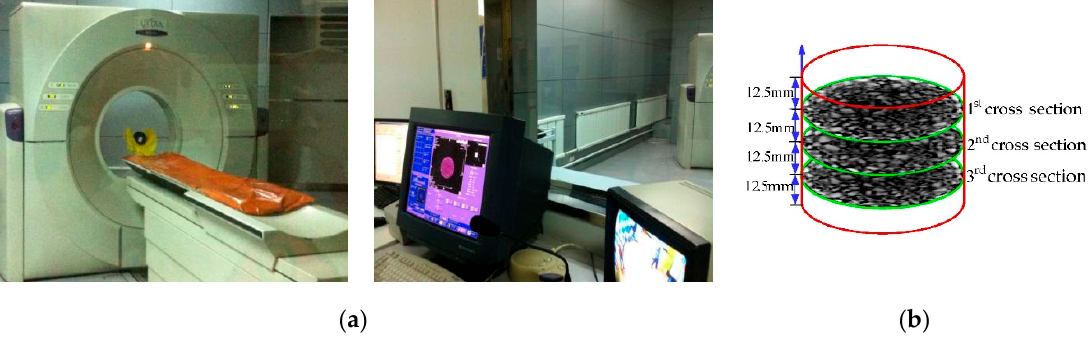
Figure 2. Digital image processing technology. ( a ) The Philips Brilliance CT scanner, ( b ) Determination of scanning layers.